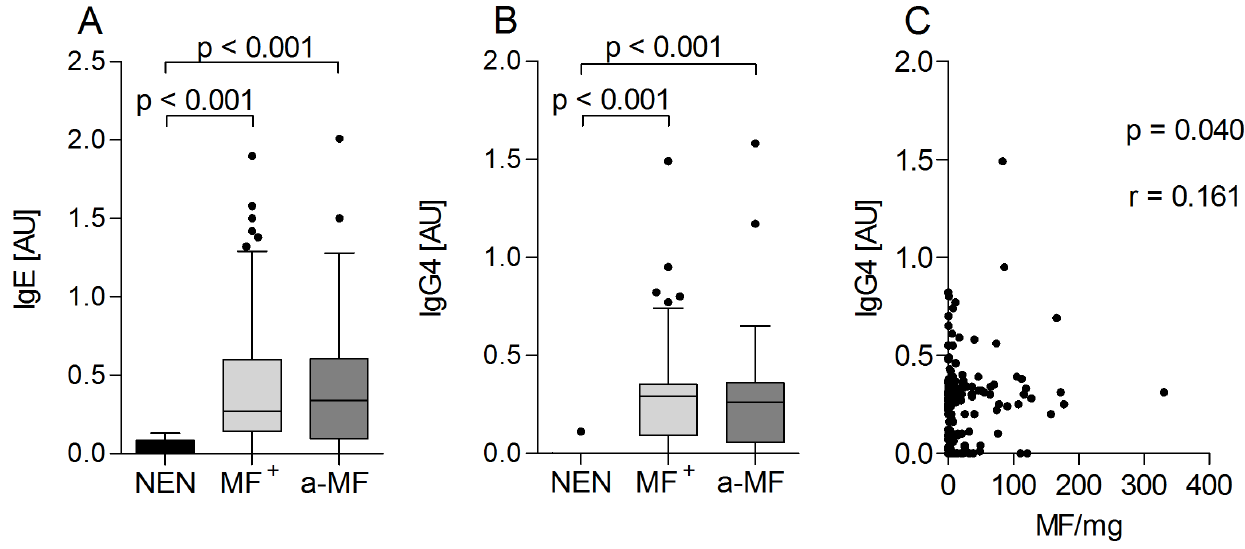
Figure 2. Lack of dermal residing MF does not alter filarial-specific antibody profiles. Plasma samples from all participants (NEN, MF + and a-MF) were investigated for the presence of filarial-specific Igs by ELISA. Plates were coated overnight with 5 m g/ml O. volvulus worm extract. Thereafter, levels of IgE (A) and IgG4 (B) were detected in all individual samples diluted 1:20 and 1:500 respectively. Data are depicted as absolute values expressed in arbitrary units [AU]. Graphs show box whiskers with median, interquartile ranges and outliers. Statistical significances between the indicated groups were obtained after Kruskal-Wallis and Mann-Whitney tests. Data in (C) show the correlation of dermal MF with the amount of filarial-specific IgG4; determined using the Spearman correlation test.